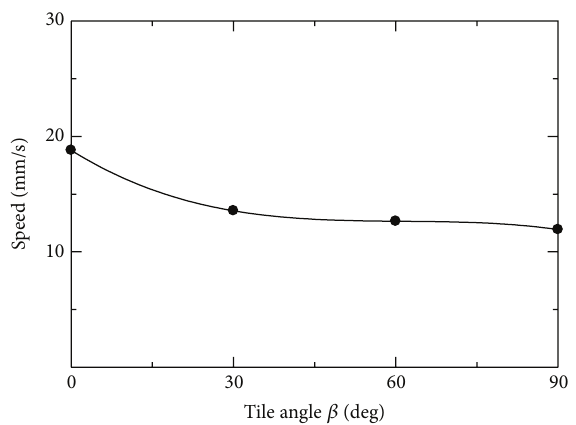
Figure 11: Relationship between tile angle 𝛽 of the iron rail and